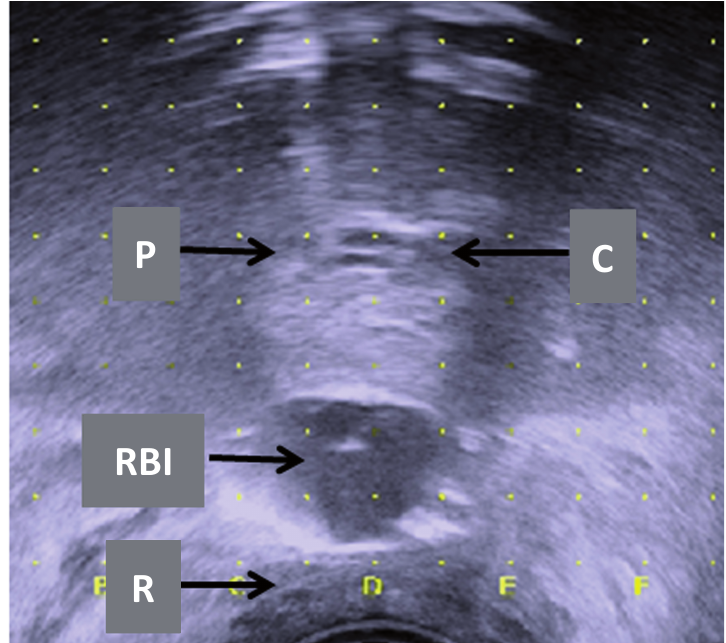
figure 7 - Axial ultrasound image: rectum balloon implant (RBI) being filled with saline between the prostate (p) and the rectum (R). note the urinary catheter (c) in the central plane, or